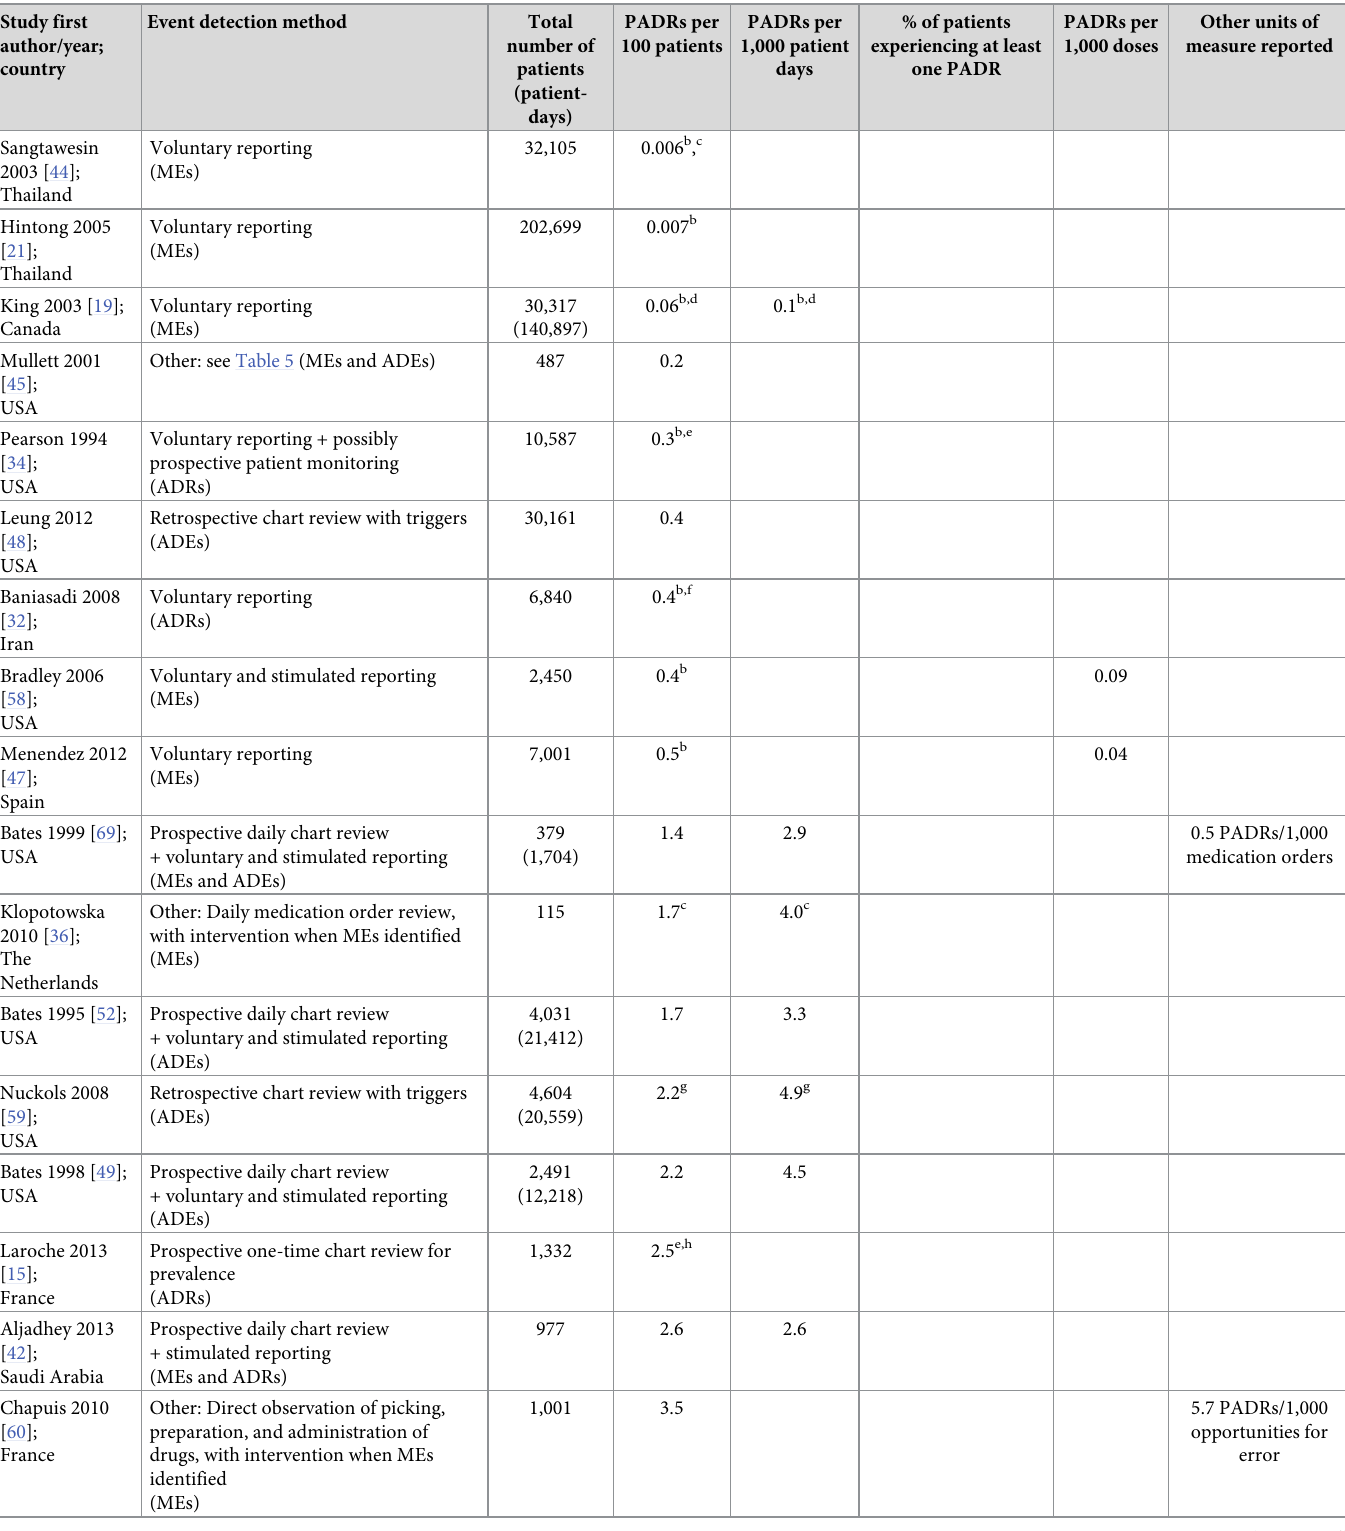
Table 6. PADR incidence a reported in the primary